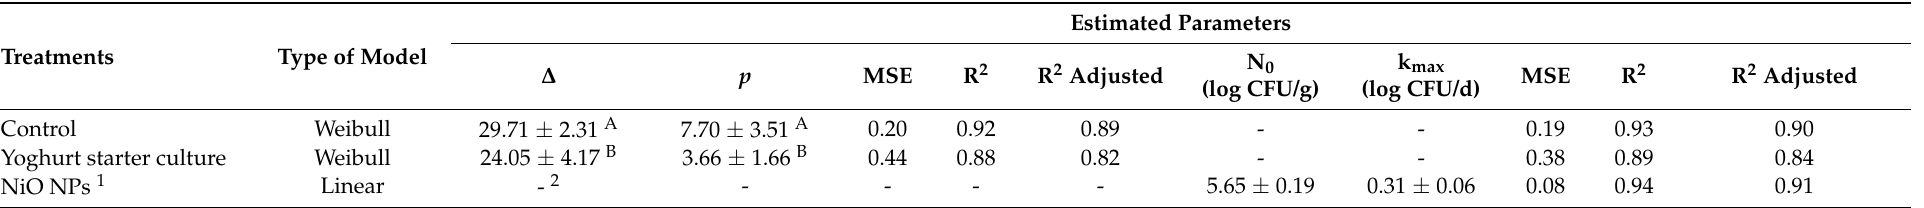
Table 2. Estimated survival parameters of the enterotoxigenic S. aureus in all kinds of the examined cheeses using Weibull and linear models.